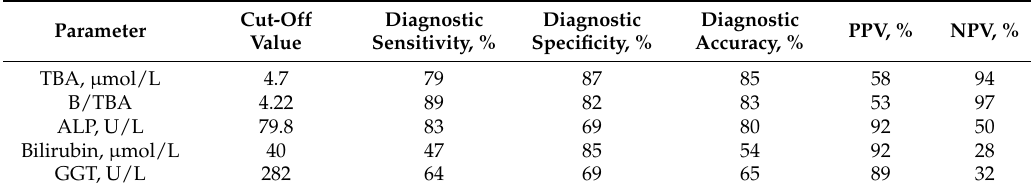
PPV: positive predictive value; NPV: negative predictive